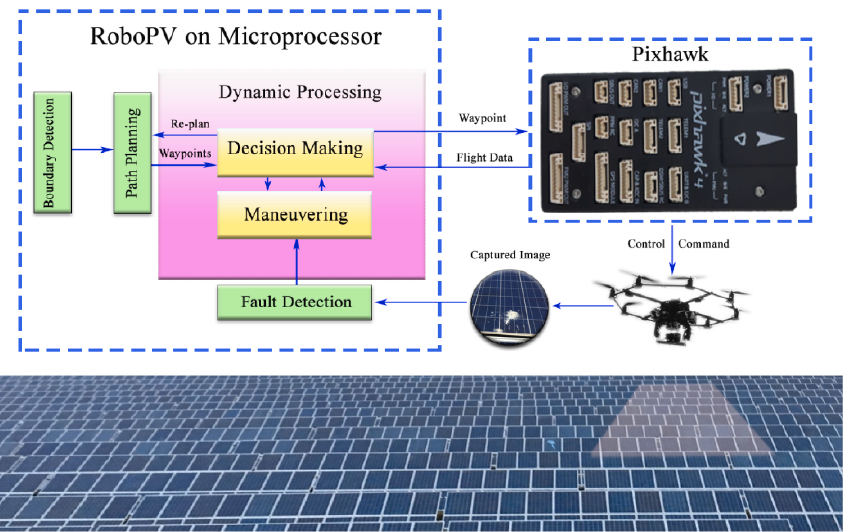
Figure 5. Overview of the on-board software package RoboPV, developed to perform the autonomous aerial monitoring of large-scale PV plants using UAVs [51].